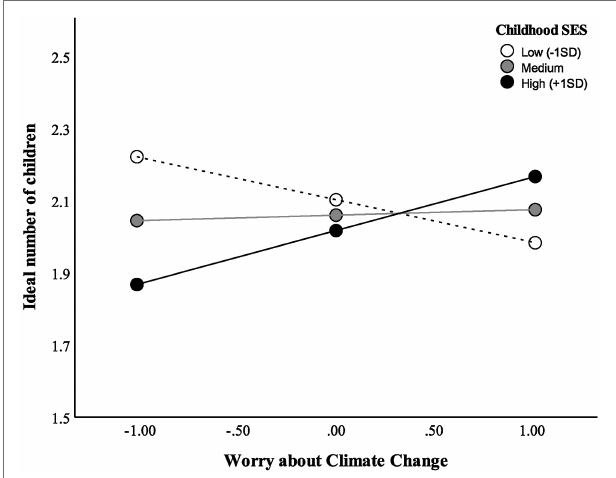
FIGURE 1 | Relationship between ideal number of children and worry about climate change, moderated by childhood SES.